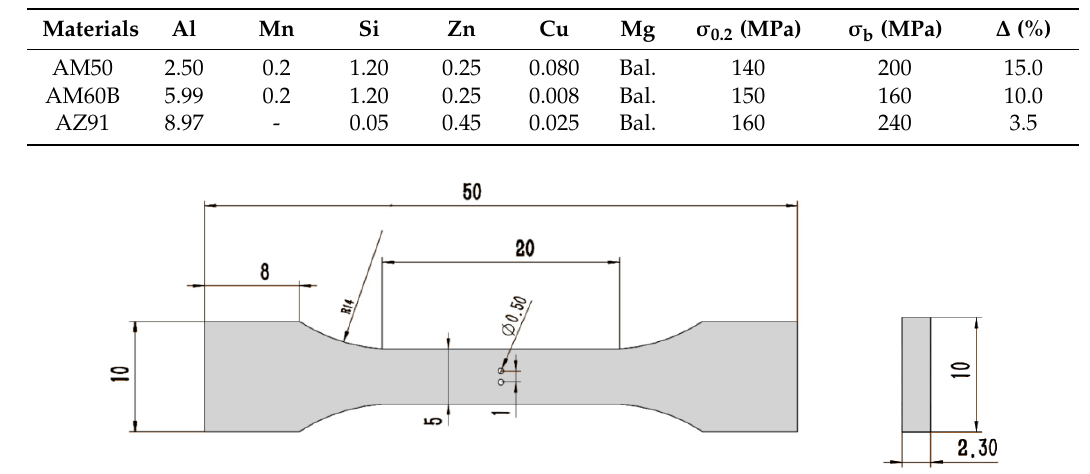
Table 1. Chemical composition and mechanical properties of cast Mg-Al alloys (wt %) at room temperature.